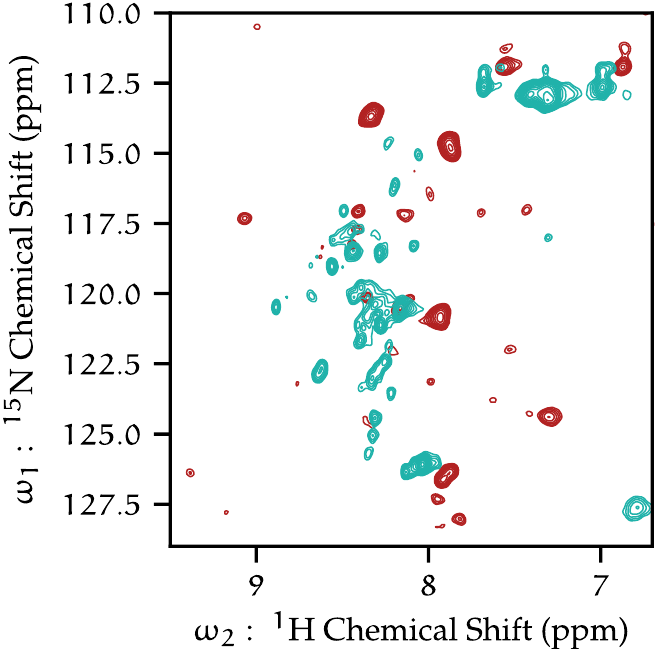
Figure 4. 1 H- 15 N HSQC of protonated KcsA at pH 7.25 (red), and fractionally deuterated KcsA at pH 4.0 (turquoise) by HR-MAS. 5 kHz MAS, 308 K, 50 mM K + .